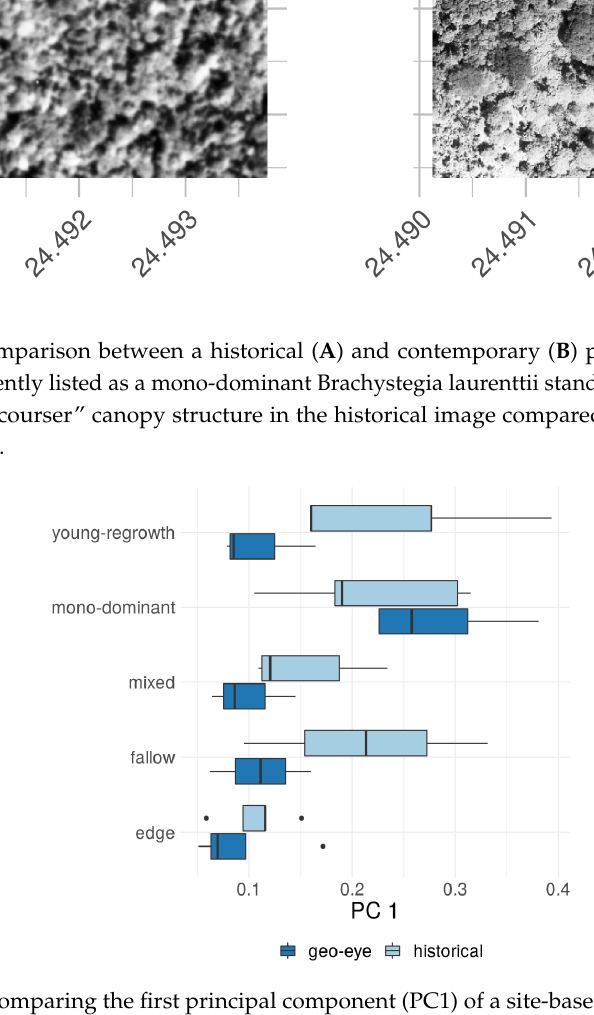
Figure 9. Boxplots comparing the first principal component (PC1) of a site-based Fourier Transform Textural Ordination (FOTO) analysis across different forest types for both contemporary (Geo-Eye) and historical orthomosaic